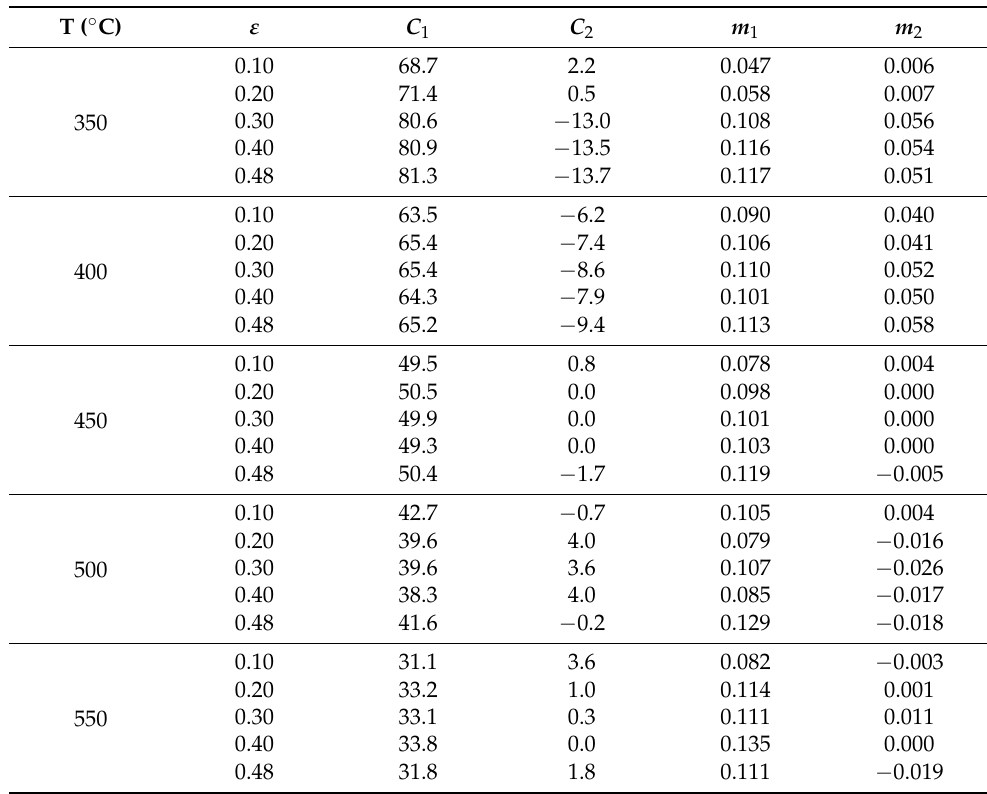
Table 2. Flow constants of the fitted